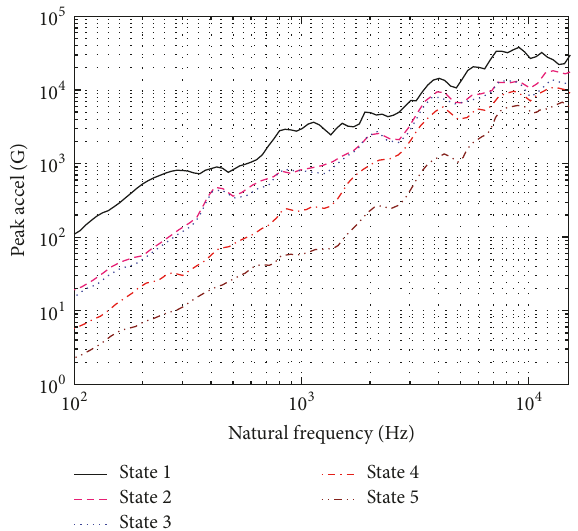
Figure 10: SRS comparison of explosive bolts under different